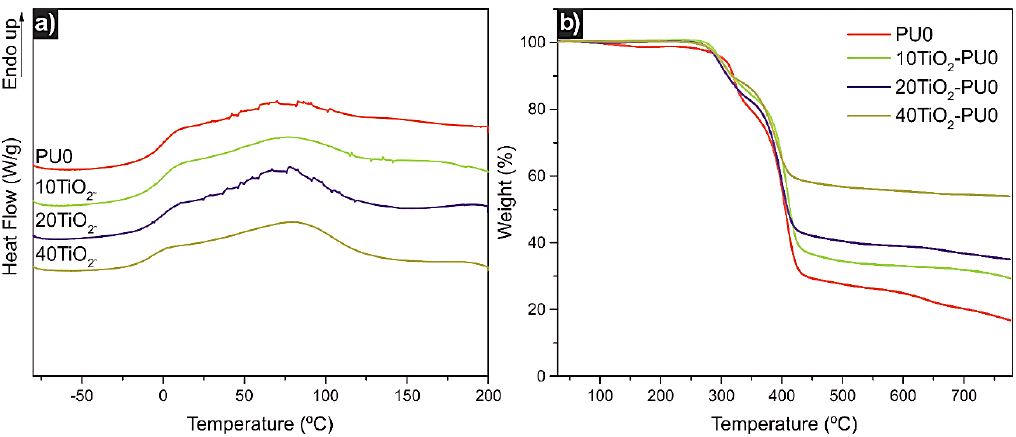
Figure 3. ( a ) Heating scan and ( b ) thermogravimetric analysis (TGA) curves of the PU0 and TiO 2 -PU0 nanocomposite films.